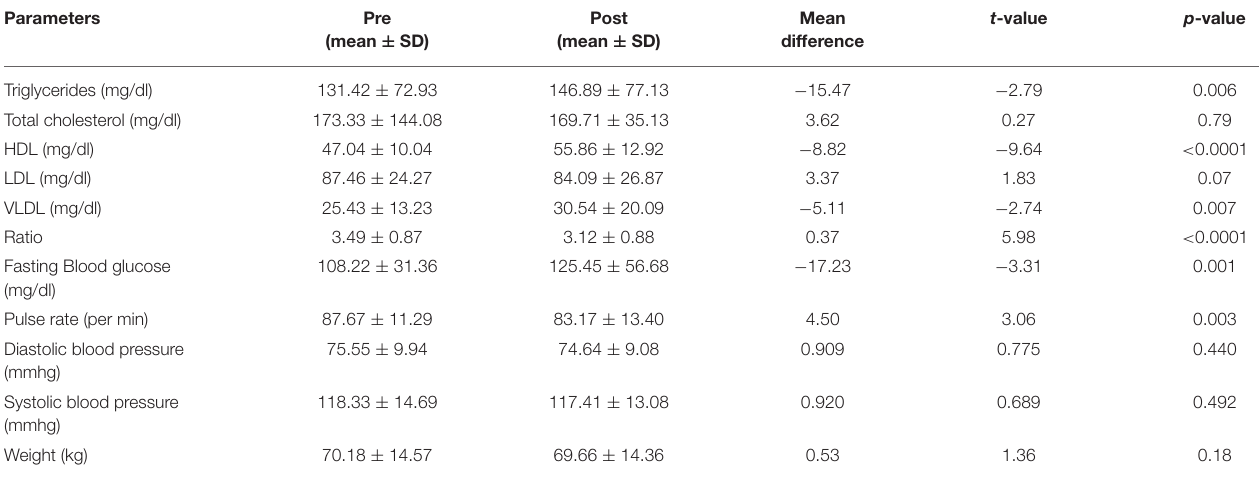
TABLE 3 | Comparative analysis of both physiological and biochemical parameters in comorbid participants after 1 month of AYUSH yoga protocol ( n = 119).